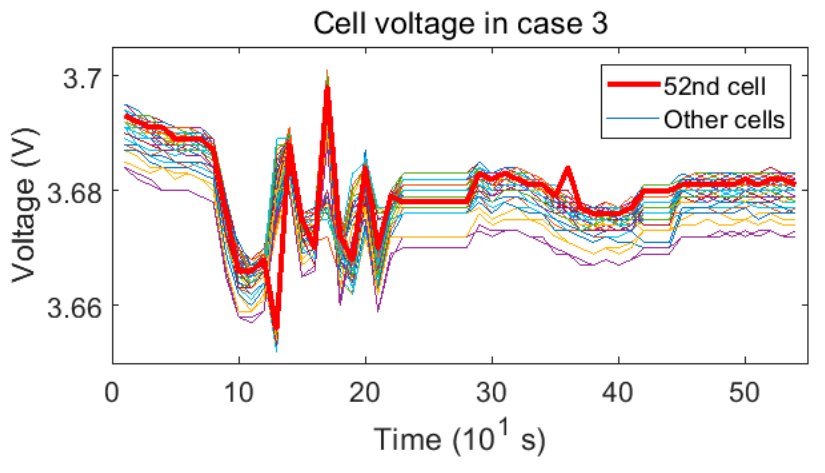
Figure 10. Voltage signal records of 90 battery cells in the third case.